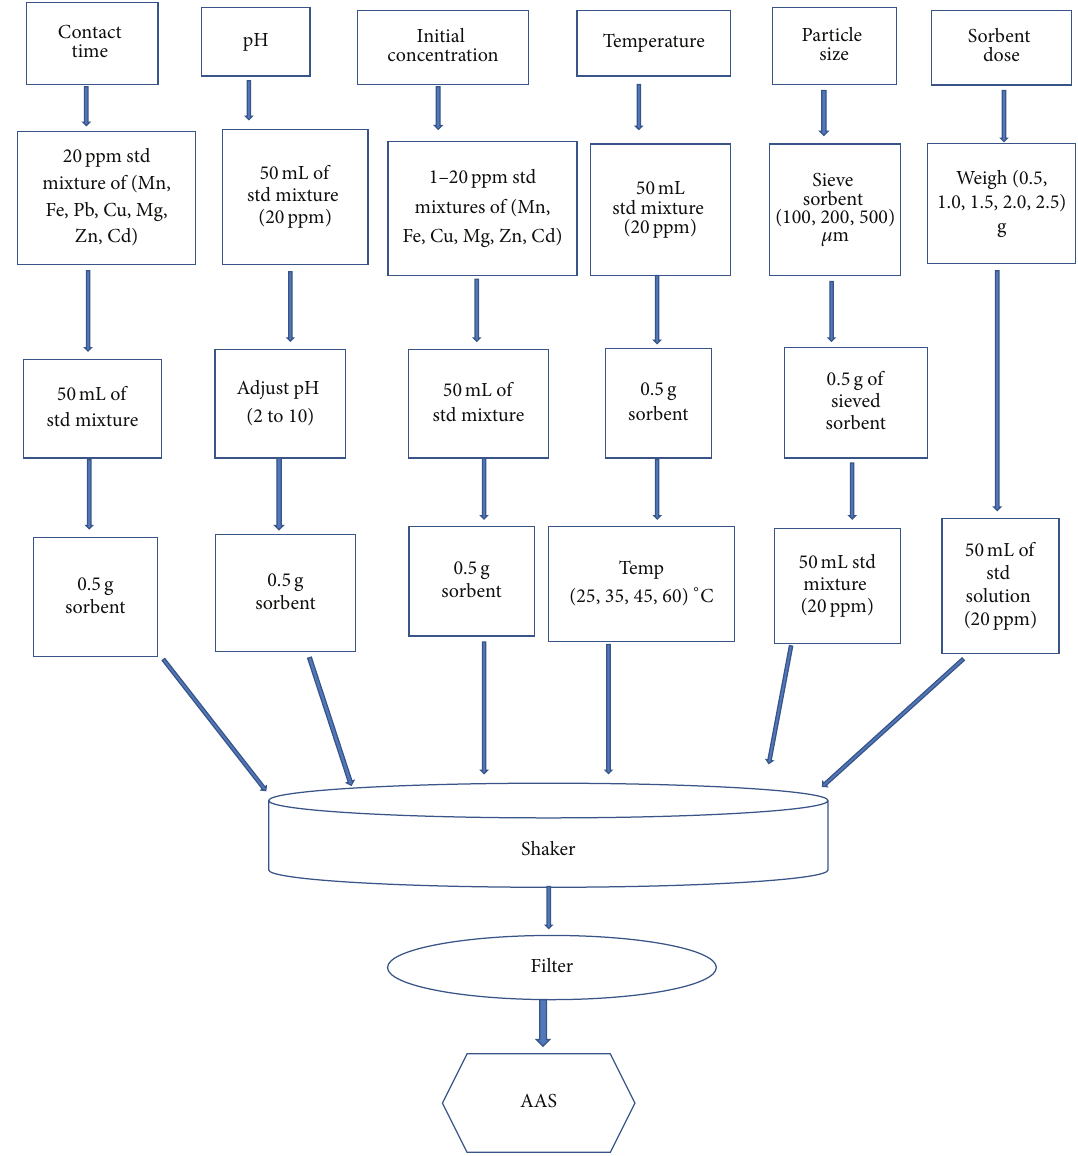
Figure 1: Summary of the optimization procedures for biosorption of metals on Morula nut shells and Moringa seed